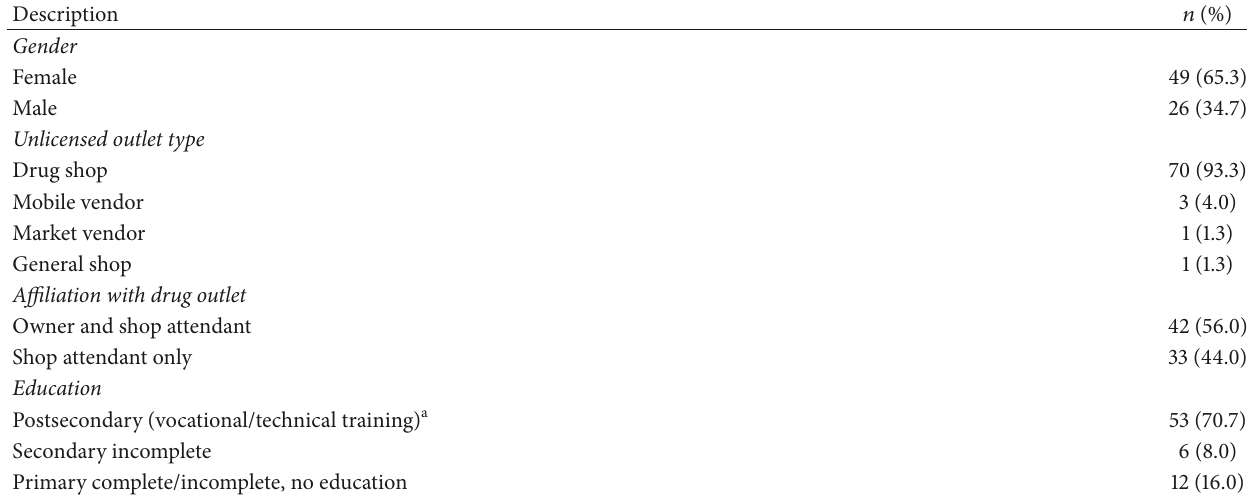
Table 2: Characteristics of participating vendors (𝑛 = 75) .